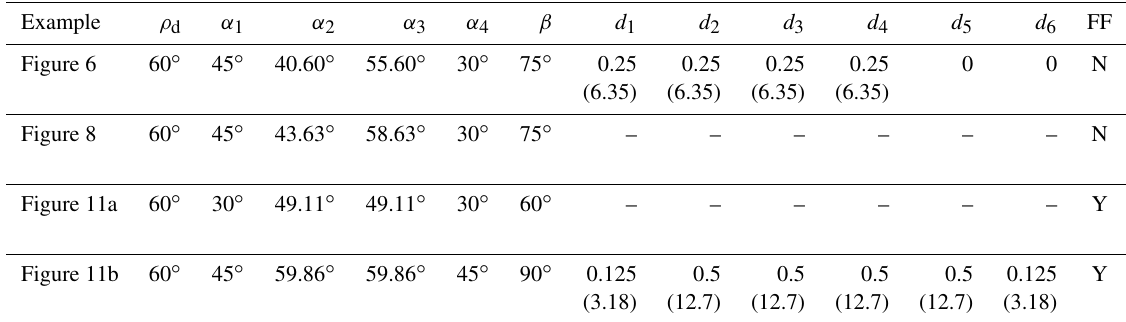
Table A2. Parameter values for spherical deploying strut ThUDS examples. Lengths are in inches (millimeters). Parameters marked “–” are not part of the technique used to create that prototype. Whether flat foldability (FF) is possible is denoted in the last column.